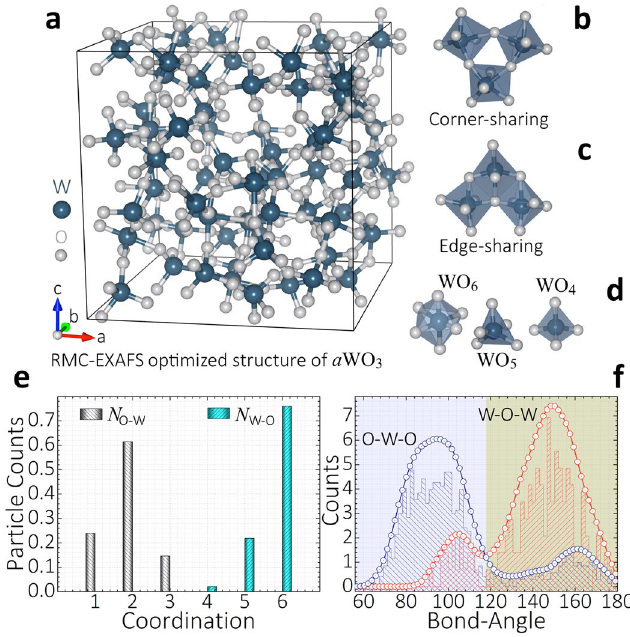
Figure 2. Atomic short-range order of a WO 3 . ( a – d ) RMC-EXAFS simulated structure of a WO 3 comprising edge- and corner-sharing distorted WO 6,5,4 units. ( e ) Distribution of atomic coordination yielding a mean value N W-O ≈ 5.74 ± 0.12 and N O-W ≈ 1.91 ± 0.03. ( f ) Edge-sharing O-W-O and corner-sharing W-O-W bond-angle distributions exhibiting maxima at 94°, 161° and at 105°, 150°,